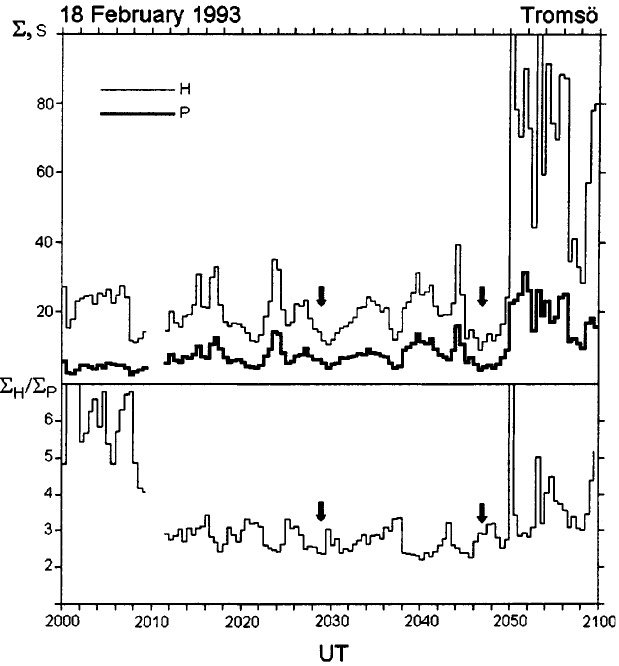
Fig. 6. Temporal variations of the high-integrated Hall and Pedersen conductivity ( top panel ) and the ratio of Hall to Pedersen conductivity ( bottom panel ) measured by EISCAT; black arrows indicate the moments under